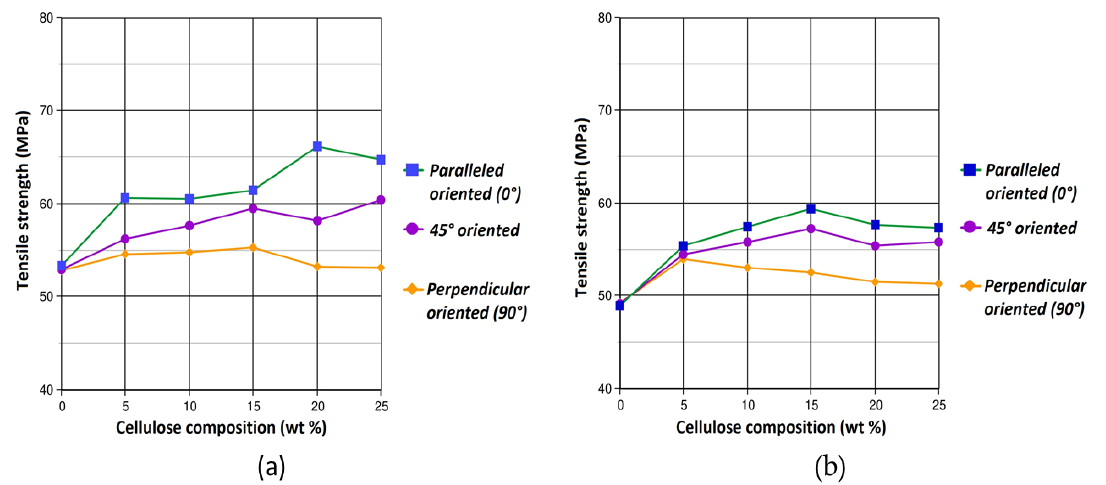
Figure 7. Tensile strength of oriented samples, ( a ) dry samples and ( b ) 48-h conditioned samples.